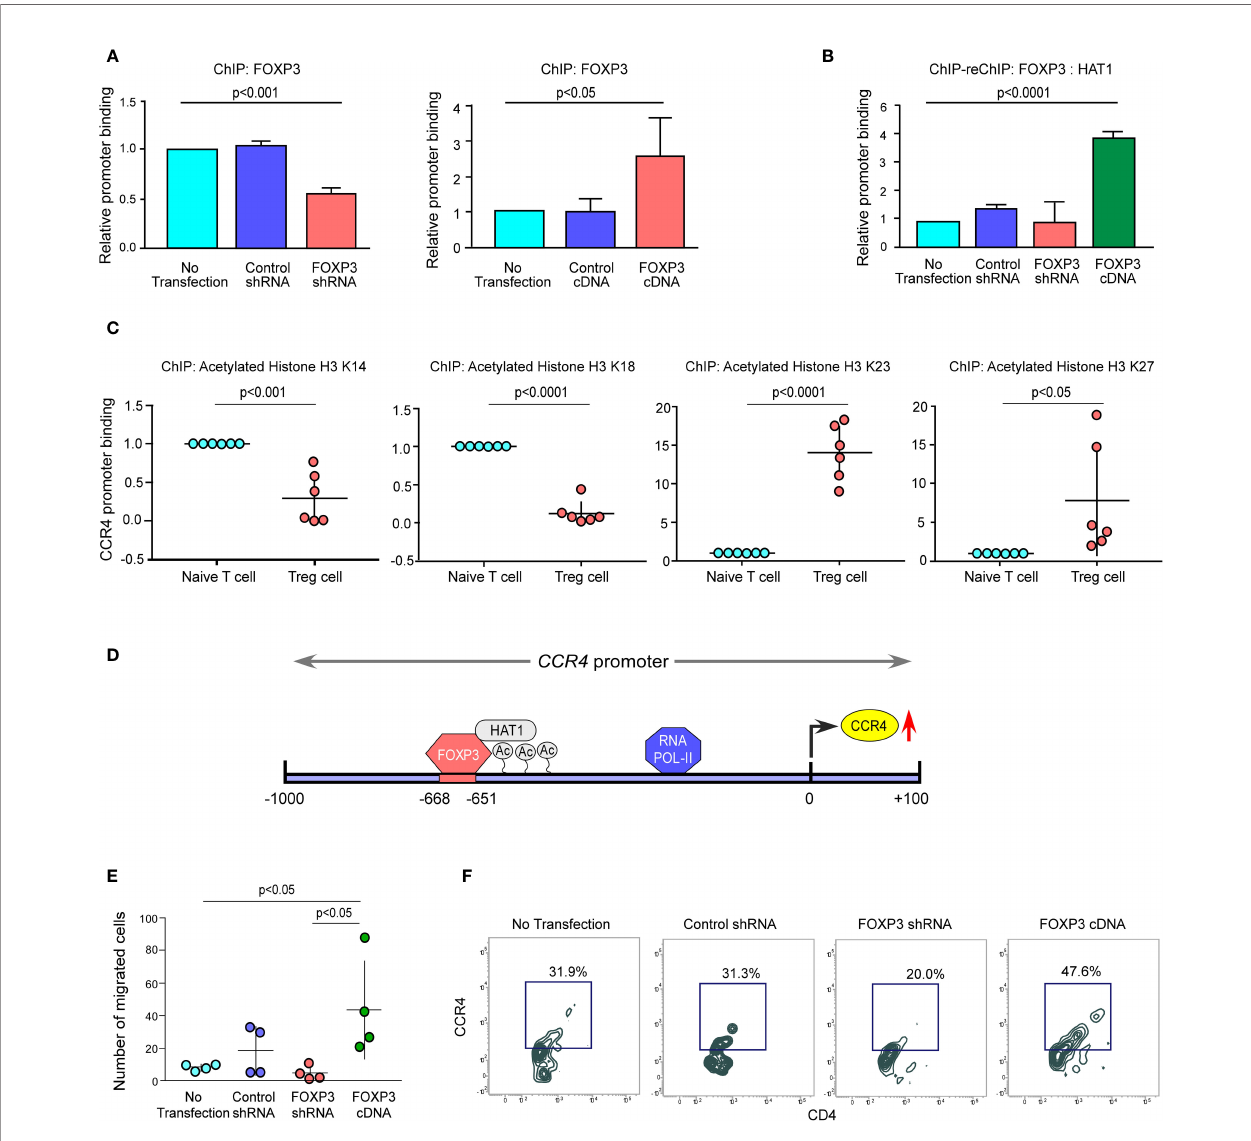
FIGURE 4 | The FOXP3/HAT1 axis epigenetically alters CCR4 promoter to promote Treg in fi ltration in tumor site. (A) The relative binding of FOXP3 to its putative responsive elements on the CCR4 promoter has been graphically depicted in FOXP3-ablated/-overexpressed Treg cells. (B) The binding of both FOXP3 and HAT1 to the CCR4 promoter in FOXP3-ablated/-overexpressed Tregs was assessed using a ChIP-Re-ChIP assay, and the results are depicted graphically. (C) Relative permissive (K23 and K27) or repressive (K14 and K18) acetylation of histone-3 was determined using a ChIP assay and depicted graphically using site-speci fi c antibodies. (D) Schematic illustration of the FOXP3-binding site on the CCR4 promoter ( − 668 bp to − 651 bp) with HAT1. (E) After 6 h, the number of FOXP3- ablated/overexpressed Treg cells in the lower chamber of the trans-well plate that migrated in response to recombinant CCL22 was counted and graphically displayed. (F) Flow cytometry was used to determine the percentage of FOXP3-ablated/overexpressed Treg cells that migrated in response to recombinant CCL22 in a trans-well plate (representative plot). The values are the mean ± SD of three sets of independent